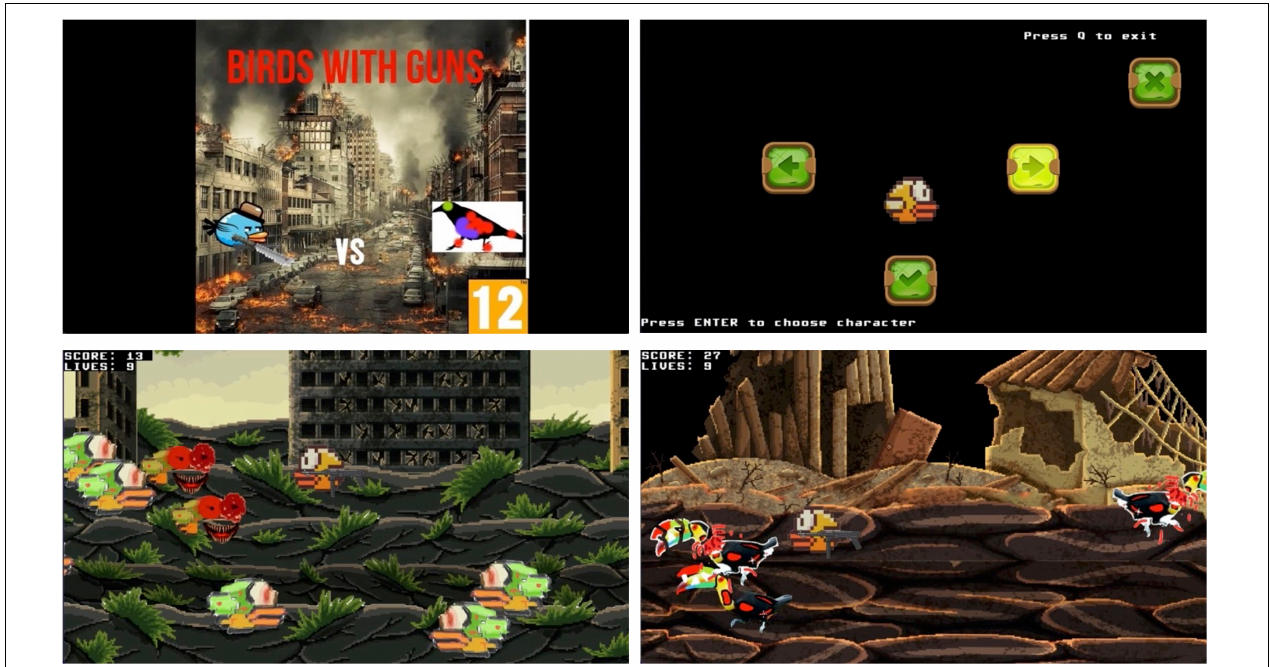
FIGURE 4 | Screenshots from the game developed by student co-creators, showing the opening screen, character menu, and levels two and three, respectively (from top left to bottom